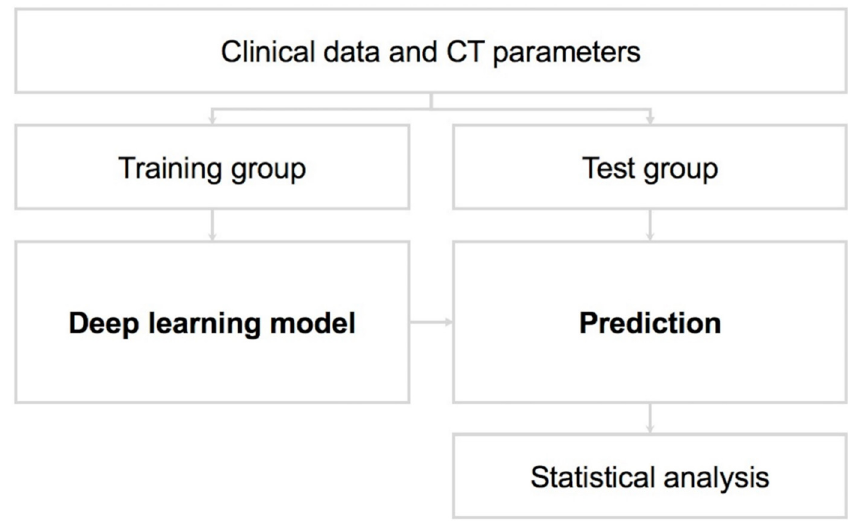
Figure 2. Training and test datasets for the deep learning model.